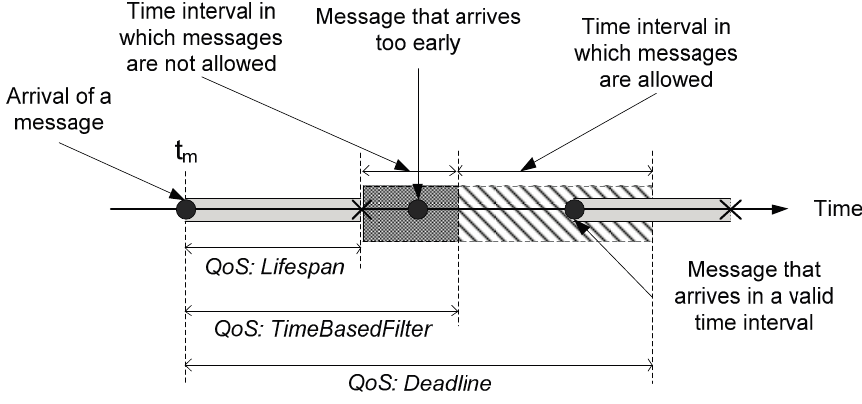
Figure 10. How the three QoS policies (lifespan, timebasedfilter and deadline) define and manage the SRVW for a single